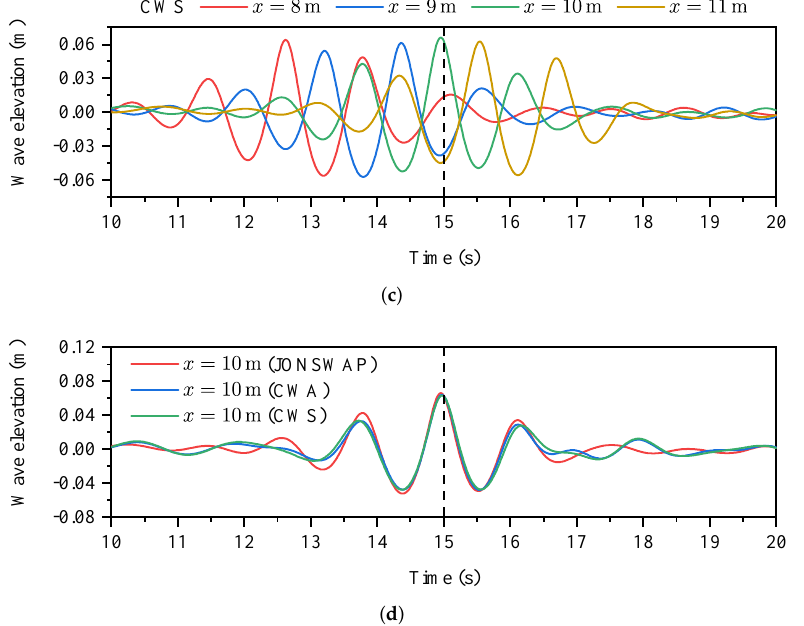
Figure 11. Simulation results of the focused waves using JONSWAP, CWA and CWS spectra (color figure available online).( a ) Time–history curves for the JONSWAP spectrum. ( b ) Time–history curves for the CWA spectrum. ( c ) Time–history curves for the CWS spectrum. ( d ) Time–history curves for the CWS spectrum.